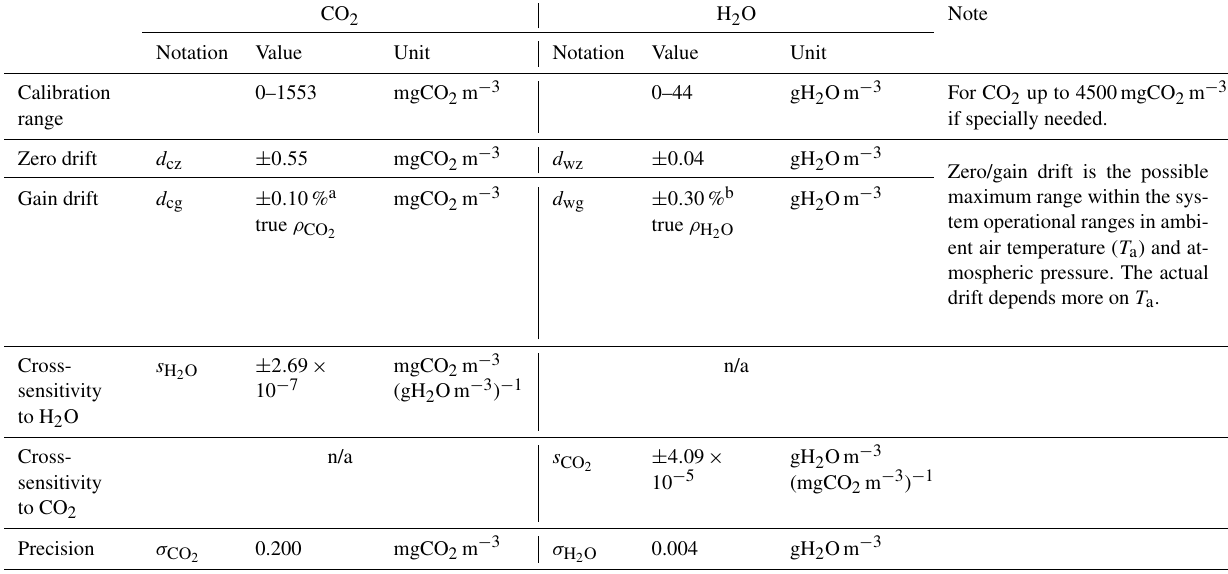
Table 1. Measurement specifications for EC150 infrared CO 2 –H 2 O analyzers (Campbell Scientific Inc., UT, USA). CO 2 H 2